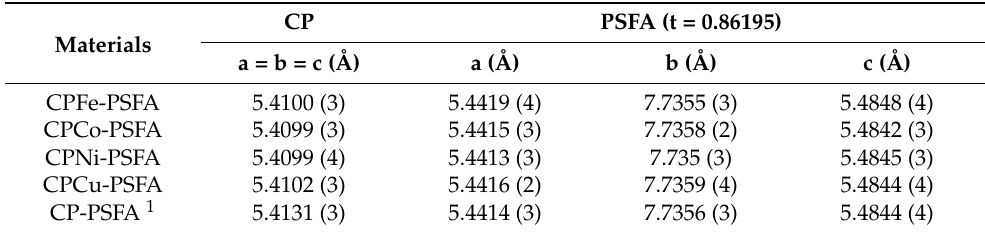
Table 1. Unit cell parameters of CPM-PSFA powders obtained by heating at 950 ◦ C for 10 h.